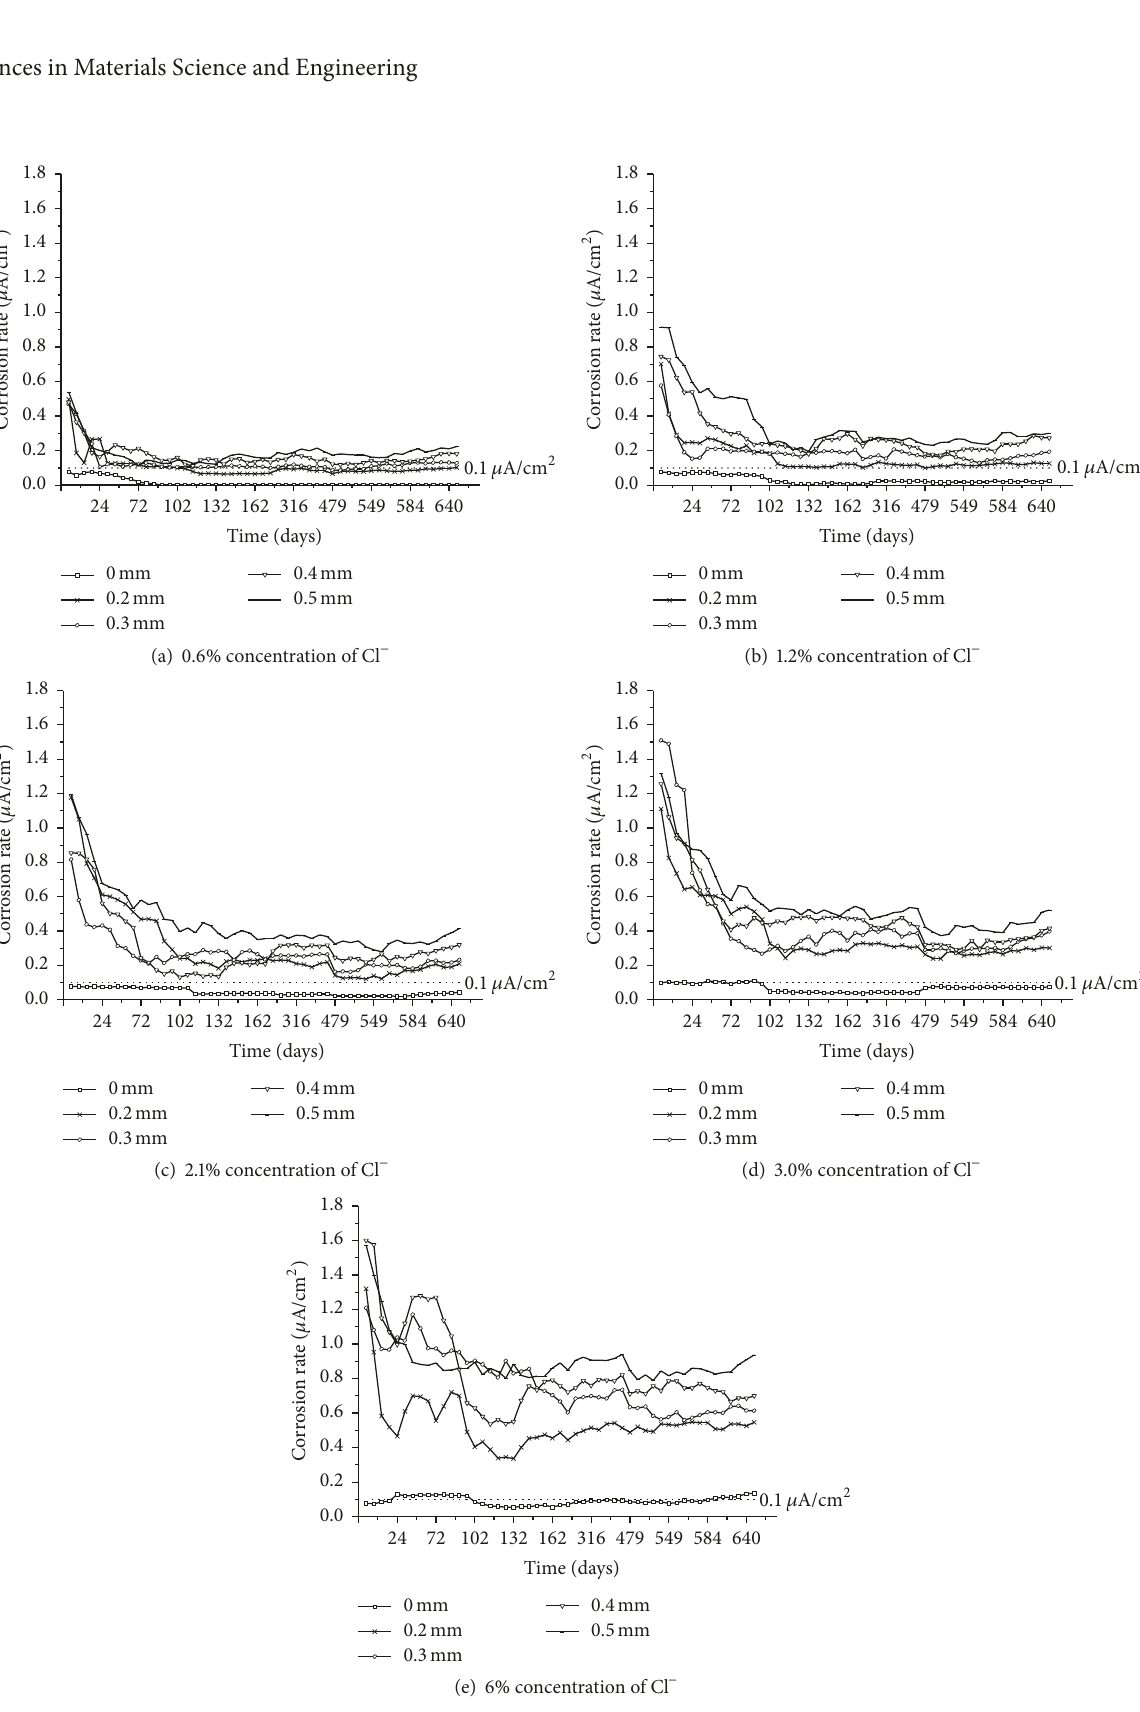
Figure 4: Time-development of the corrosion rate in different concentrations of